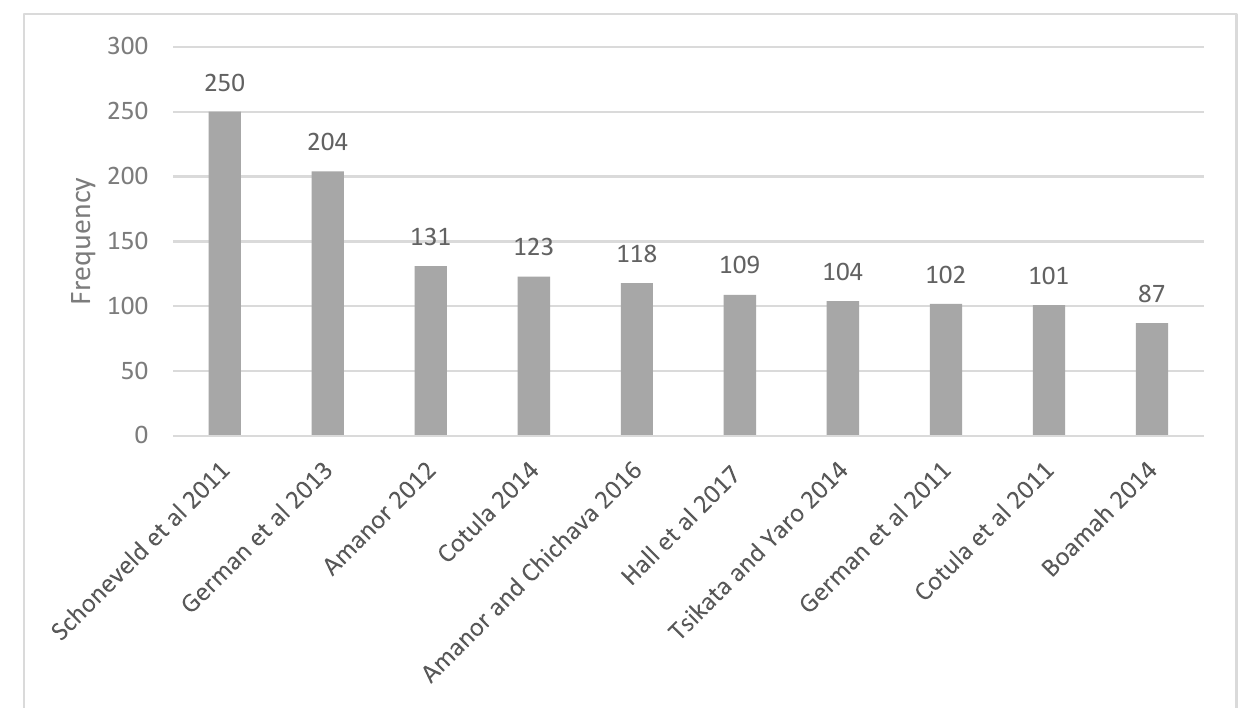
Figure 1. Top-10 Most-Cited Works, by Author.